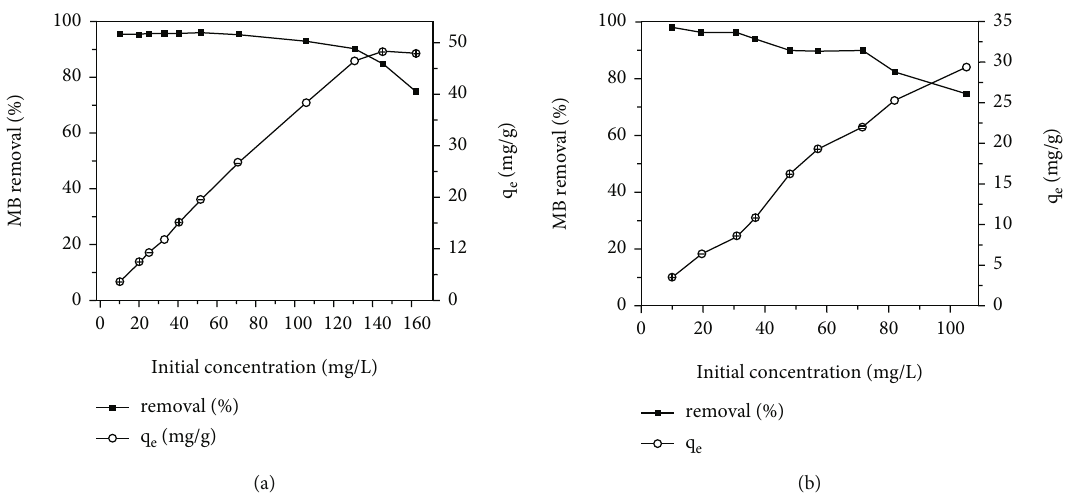
Figure 8: Initial MB concentration variation (a) BB and (b) EVML(conditions: adsorbent dose 2.5g/L, shaking speed 200 rpm, and temperature 25 ± 1 ° C ).